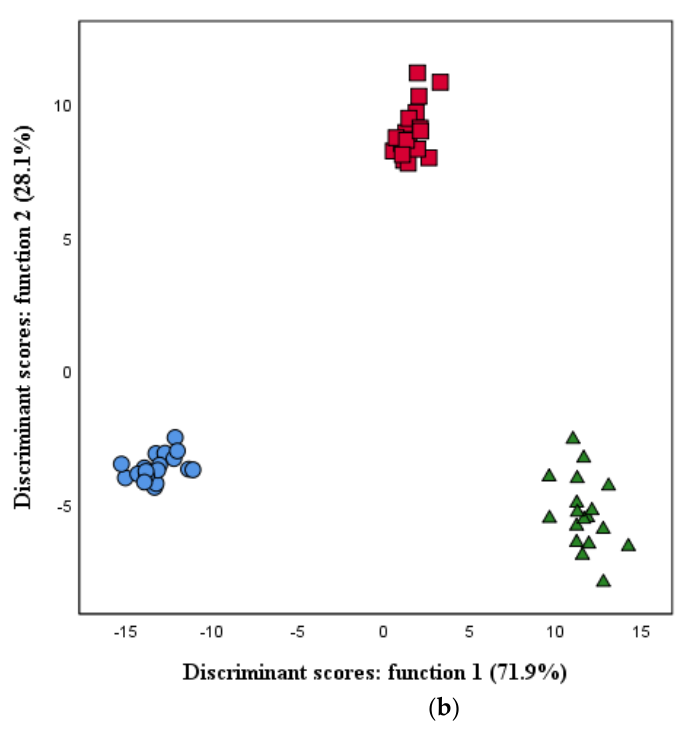
Figure 1. Spatial distribution of TP ( a ) and ST ( b ) markers following the distribution set by the canonical discriminant functions coefficients. Function 1 accounted for 71.9% of the variation, while function 2 accounted for 28.1%. Together, both functions covered 100% of the variation.